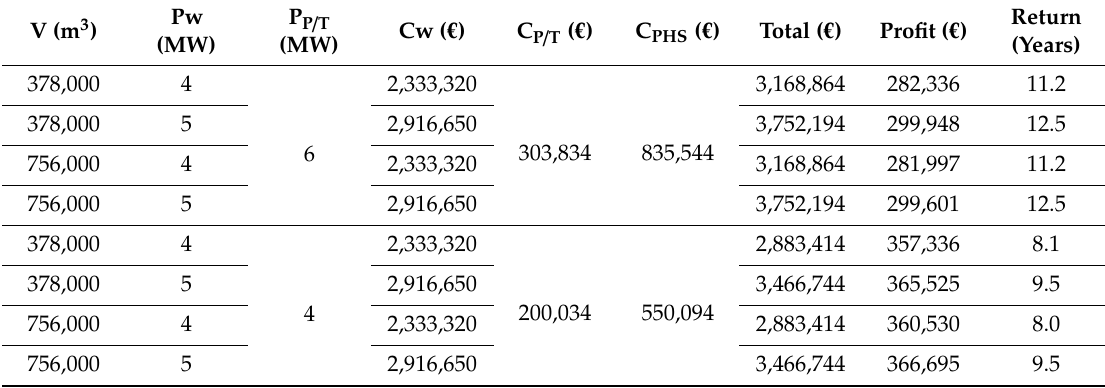
Table 2. Estimation of costs and associated profits as a function of the installed power.